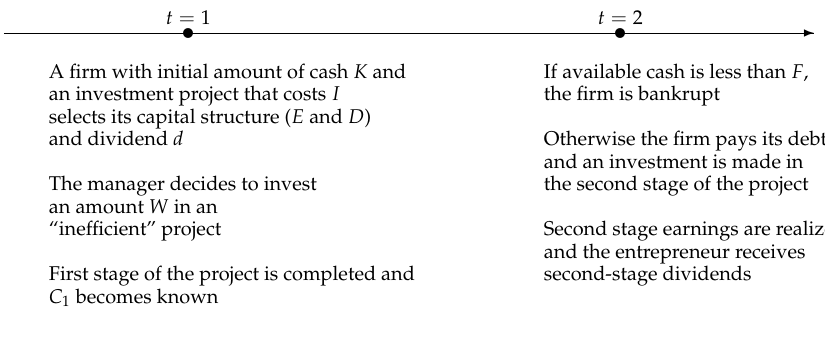
Figure 1. The sequence of